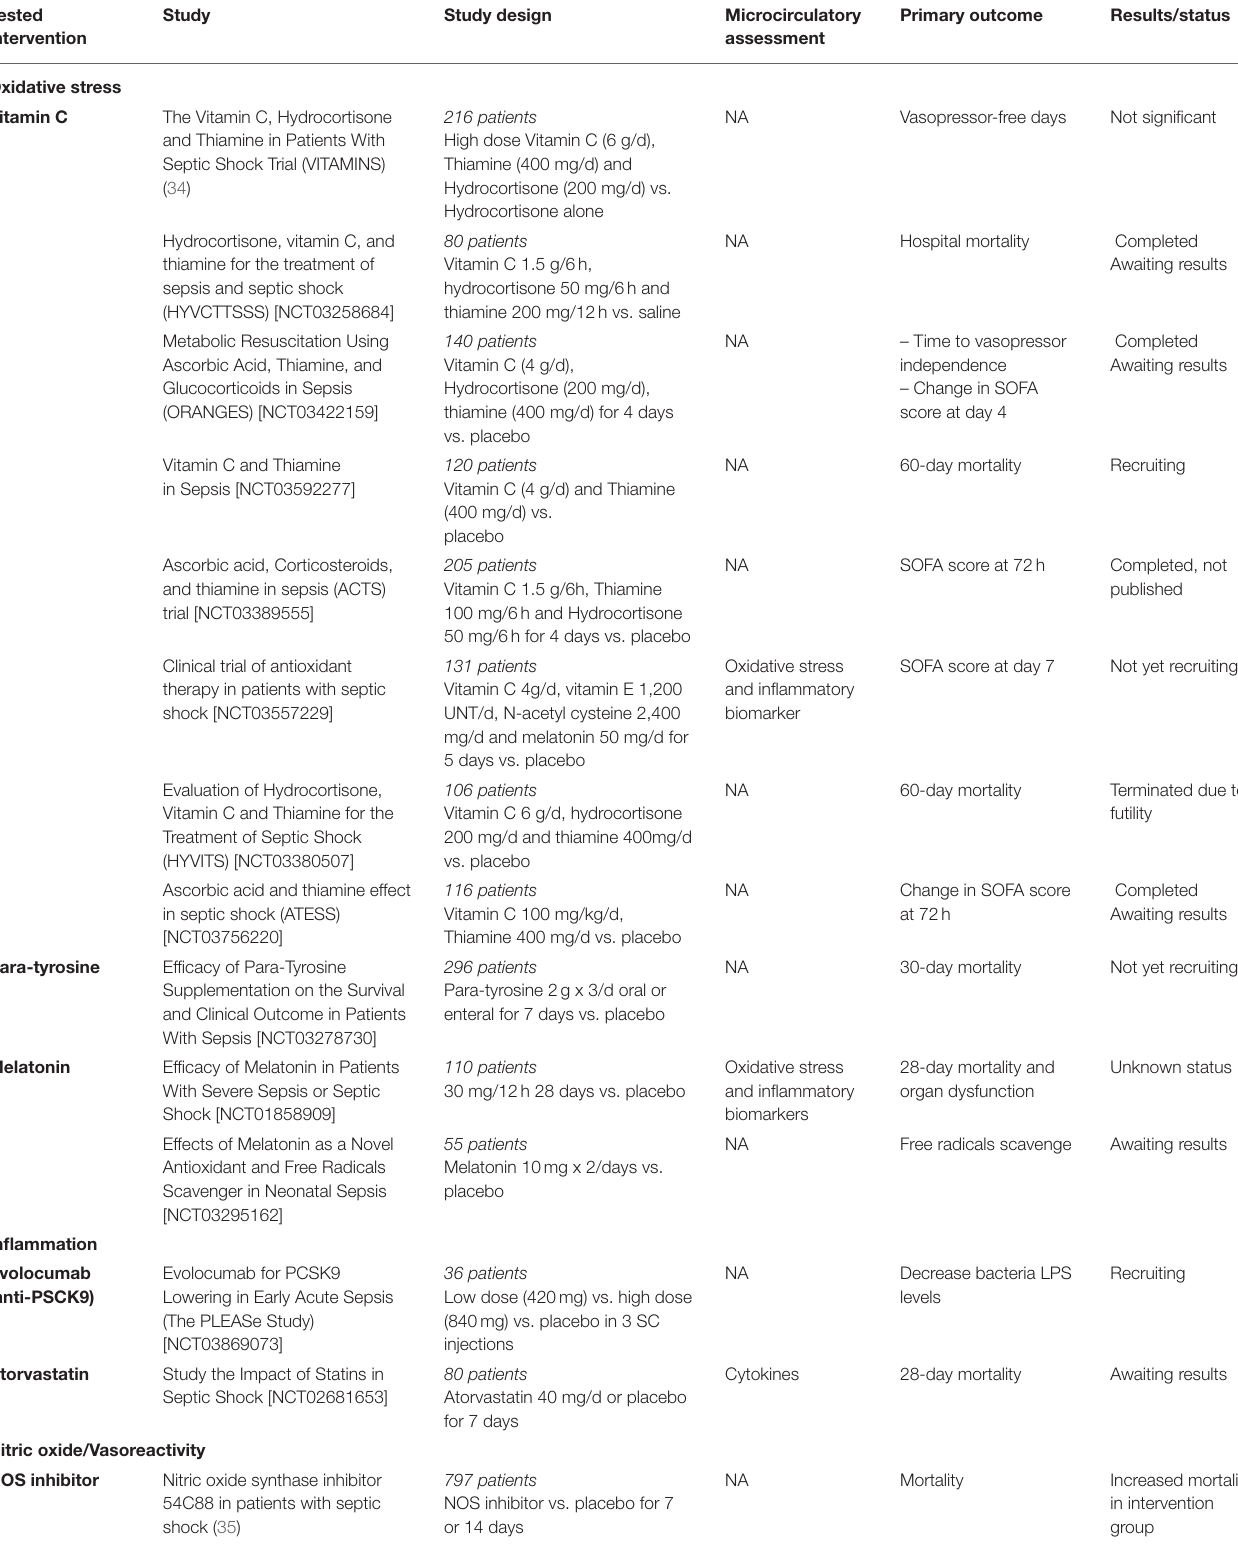
TABLE 2 | Human randomized controlled trials targeting endothelium and microcirculation in sepsis and septic shock. Tested